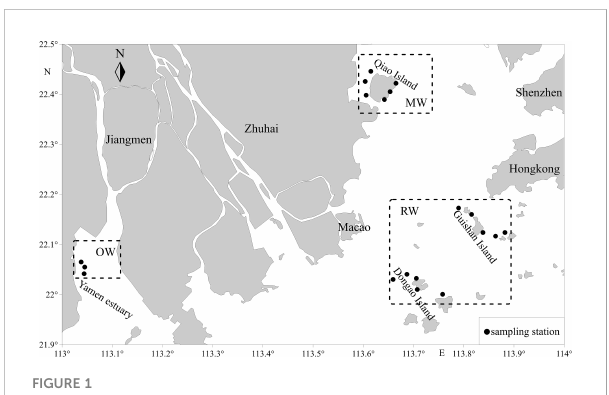
FIGURE 1 Sampling regions for A. latus in the Wanshan